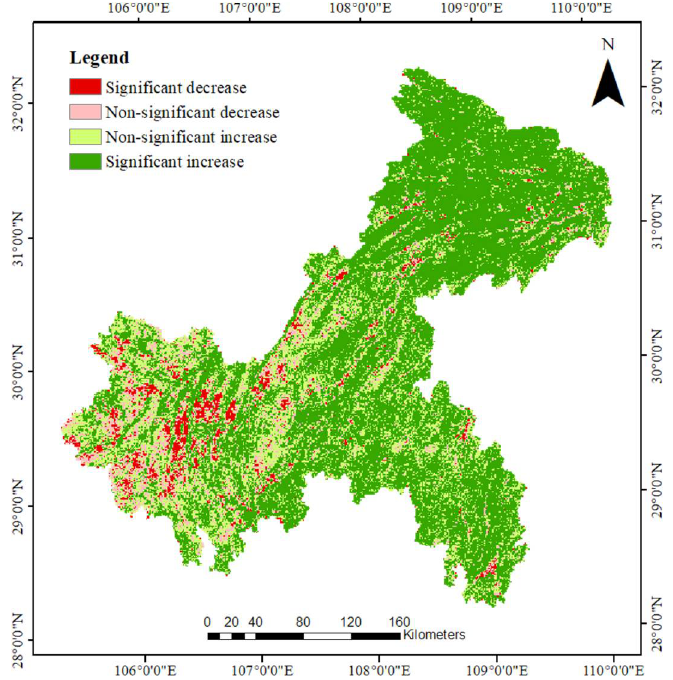
Figure 4. Changes in vegetation cover from 2000–2020. Table 2. Area and proportion of different vegetation-cover changes in Chongqing.